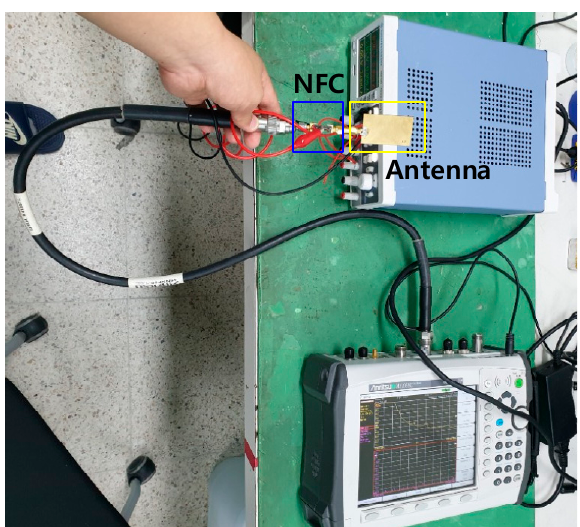
Figure 5. Impedance measurement environment.